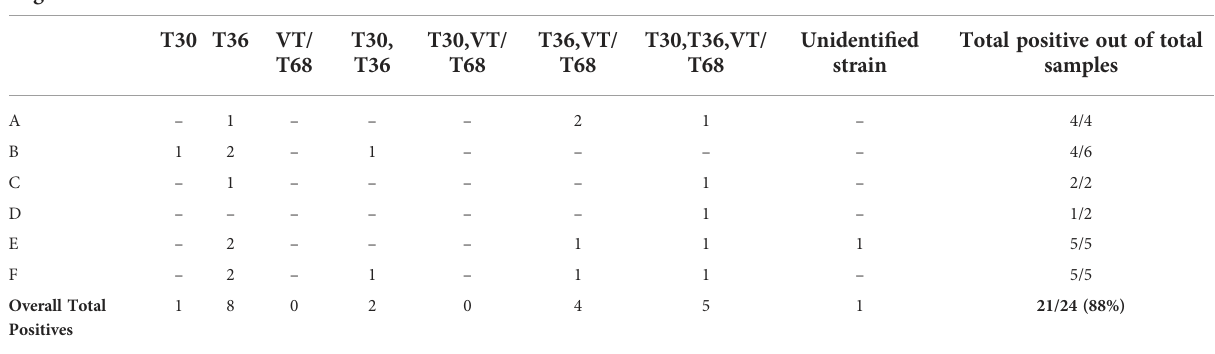
TABLE 4 Summary of citrus tristeza virus (CTV) prevalence and diversity in Asian citrus psyllid ( Diaphorina citri ; ACP) samples tested during the 5- year (2018-2022) general survey. Florida